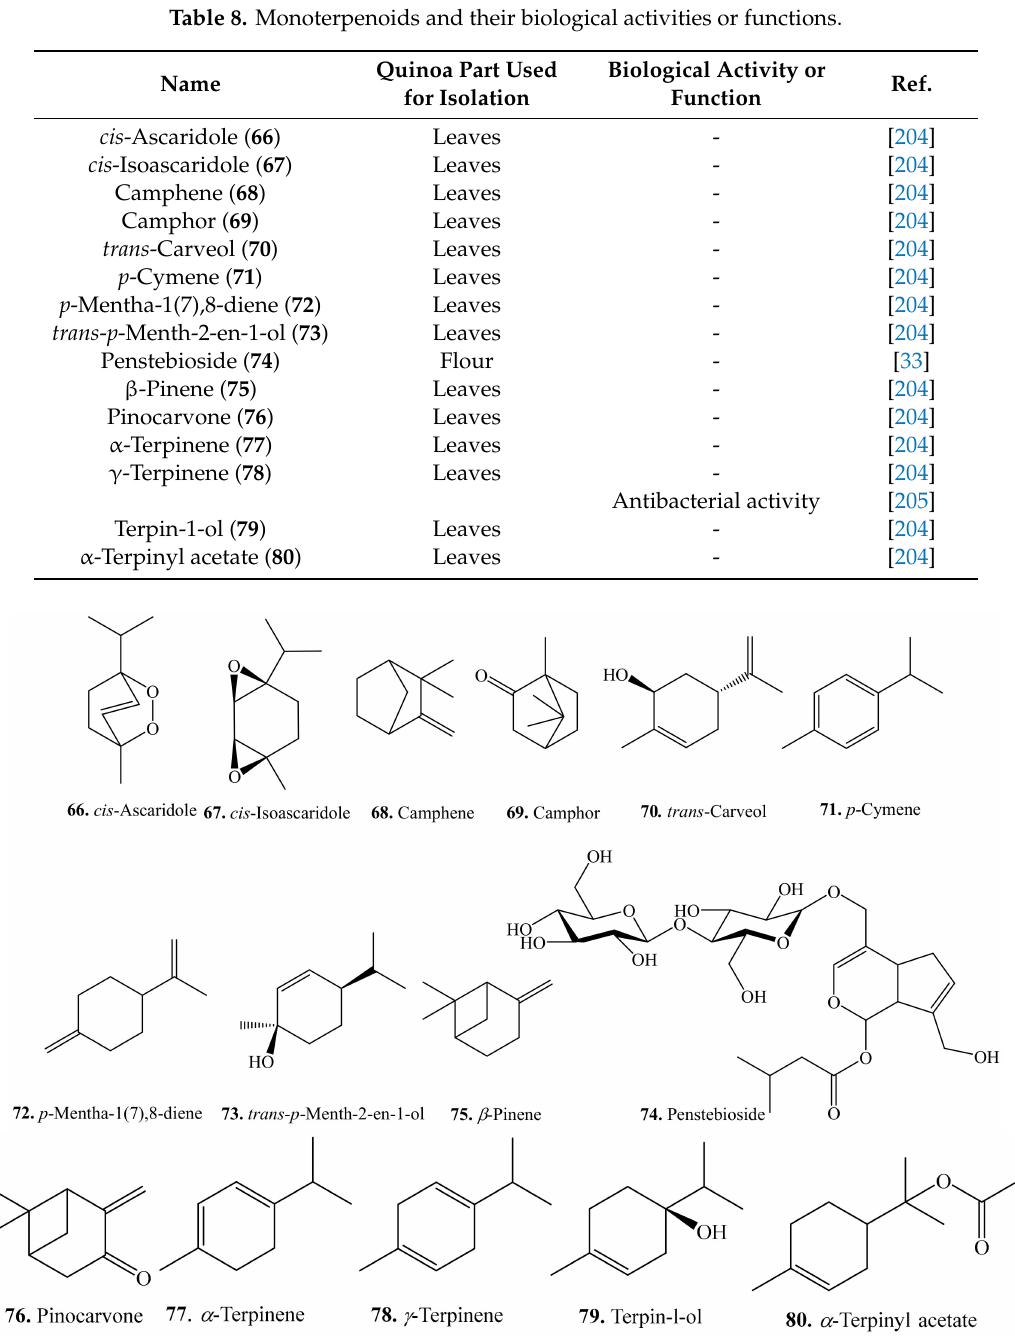
Figure 8. Structures of the monoterpenoids isolated from